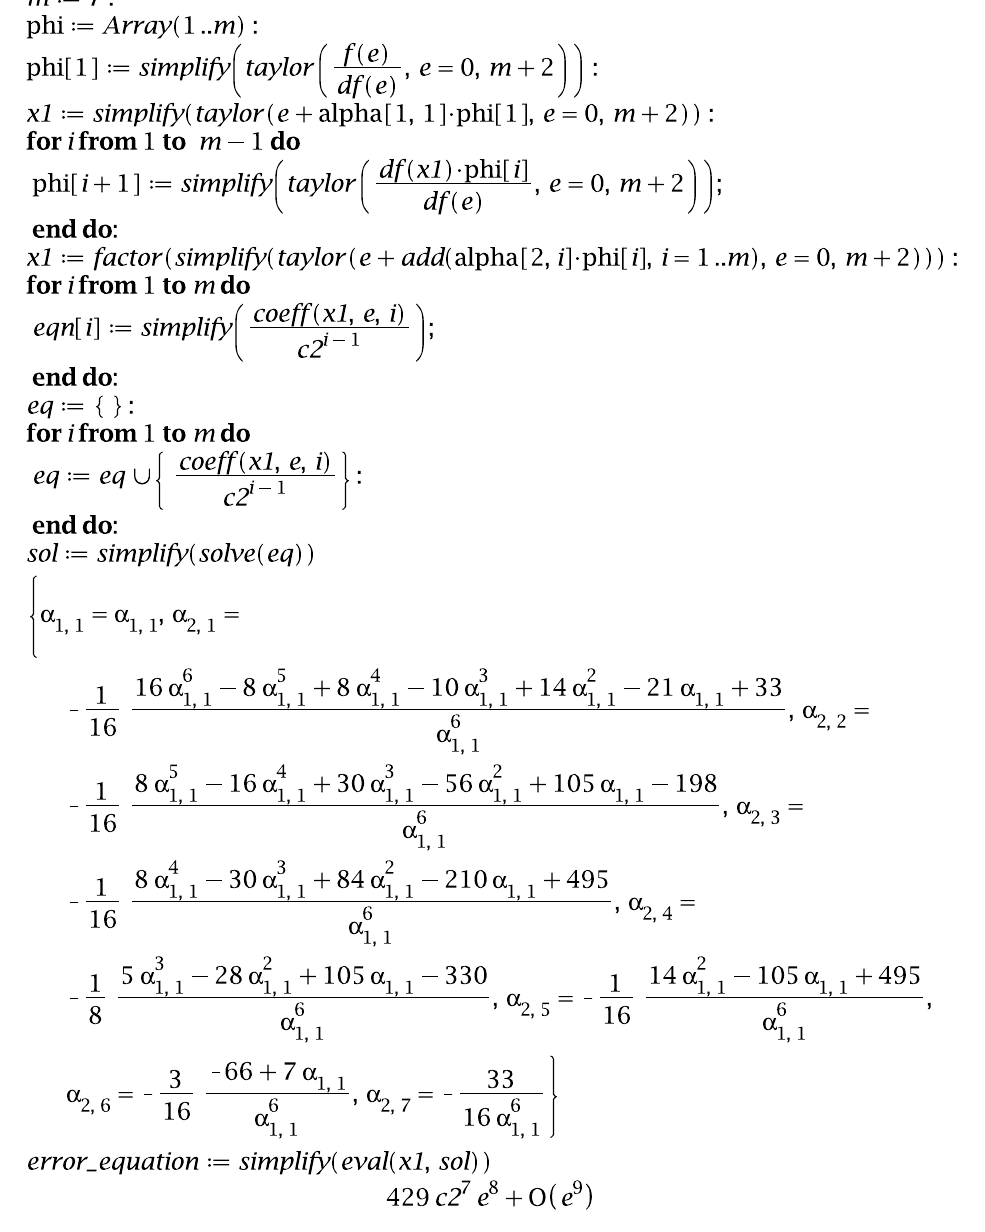
Figure 2. Iterative method Equation (6) for arbitrary finite α 1,1